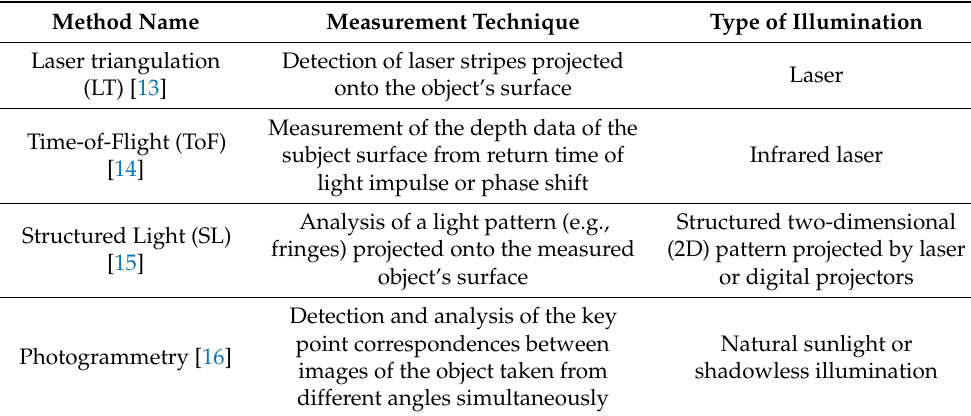
Table 1. A short summary of the 3D reconstruction methods used for human body